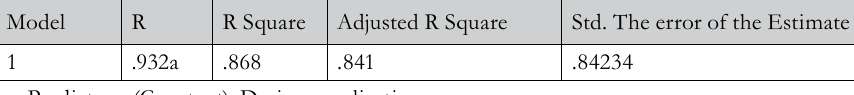
Tab. 12 – Regression model summary – Hungary. Source: own processing